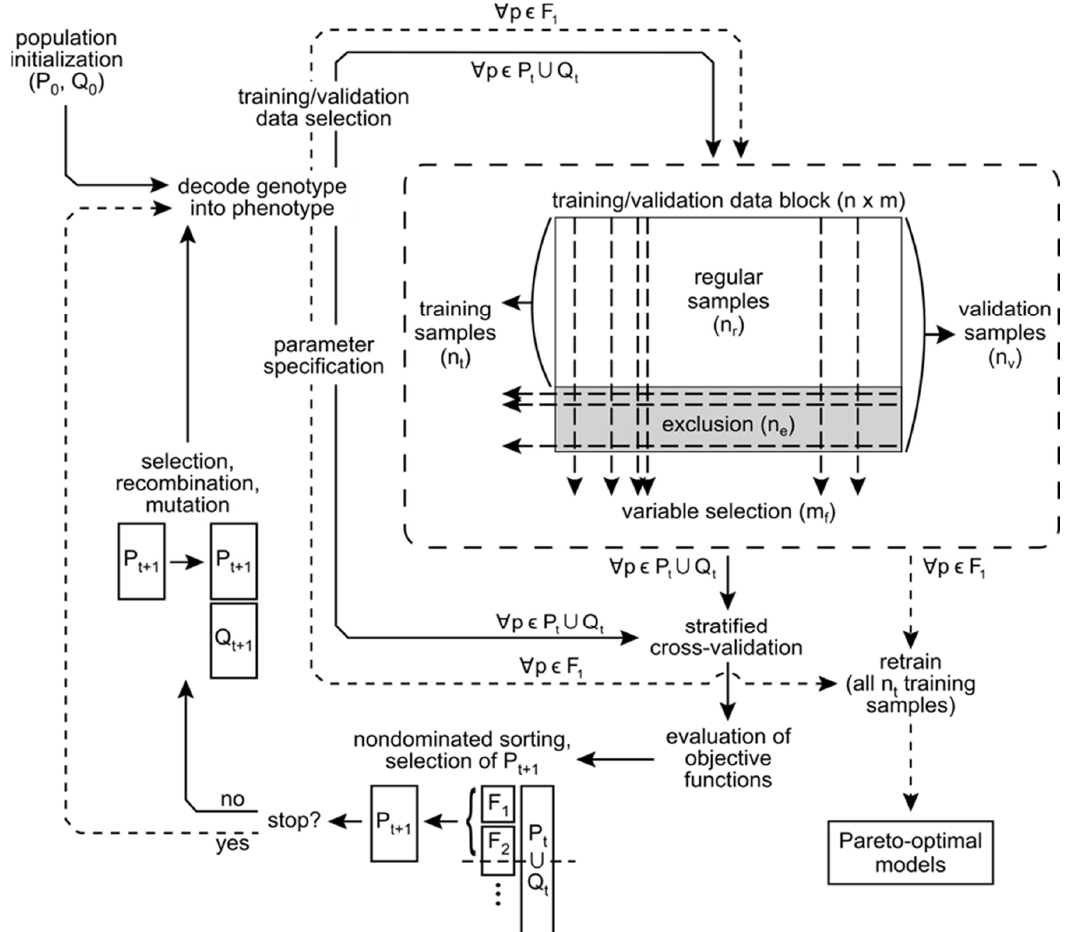
Figure 3. Multi-objective support vector regression algorithm implementation. Following selection of training and validation data, SVR models are fit and predictions made using LIBSVM. Objective function values are estimated by repeated cross-validation using all samples, and serve as the basis for population sorting, parent selection, and genetic operations embedded within the NSGA-II. CV estimates of objective function values are assigned to each member of the current population.